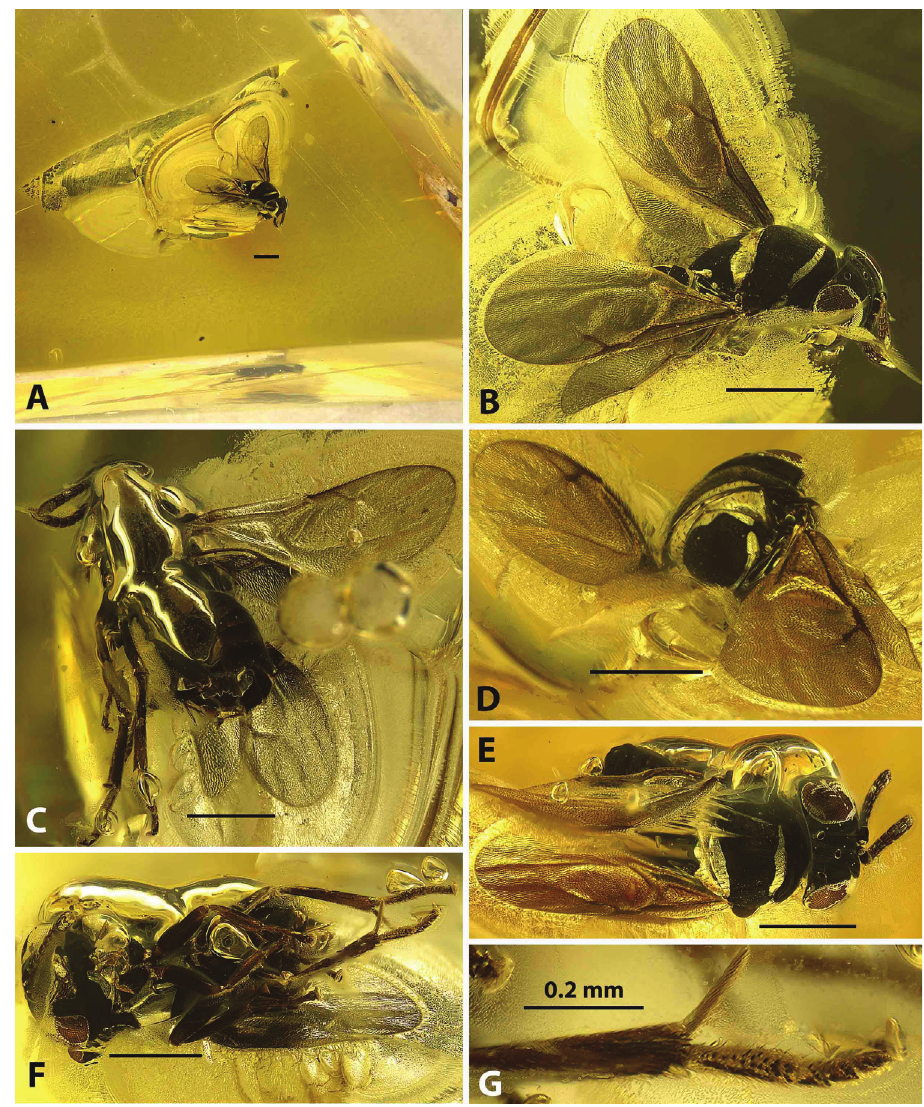
Figure 4. S. glaesaria , female, new Rovno specimen A general view in piece of amber B dorsolateral C lateral D posterodorsal E dorsal F ventral G apex of mid leg. Scale bars: 0.5 mm ( A–F